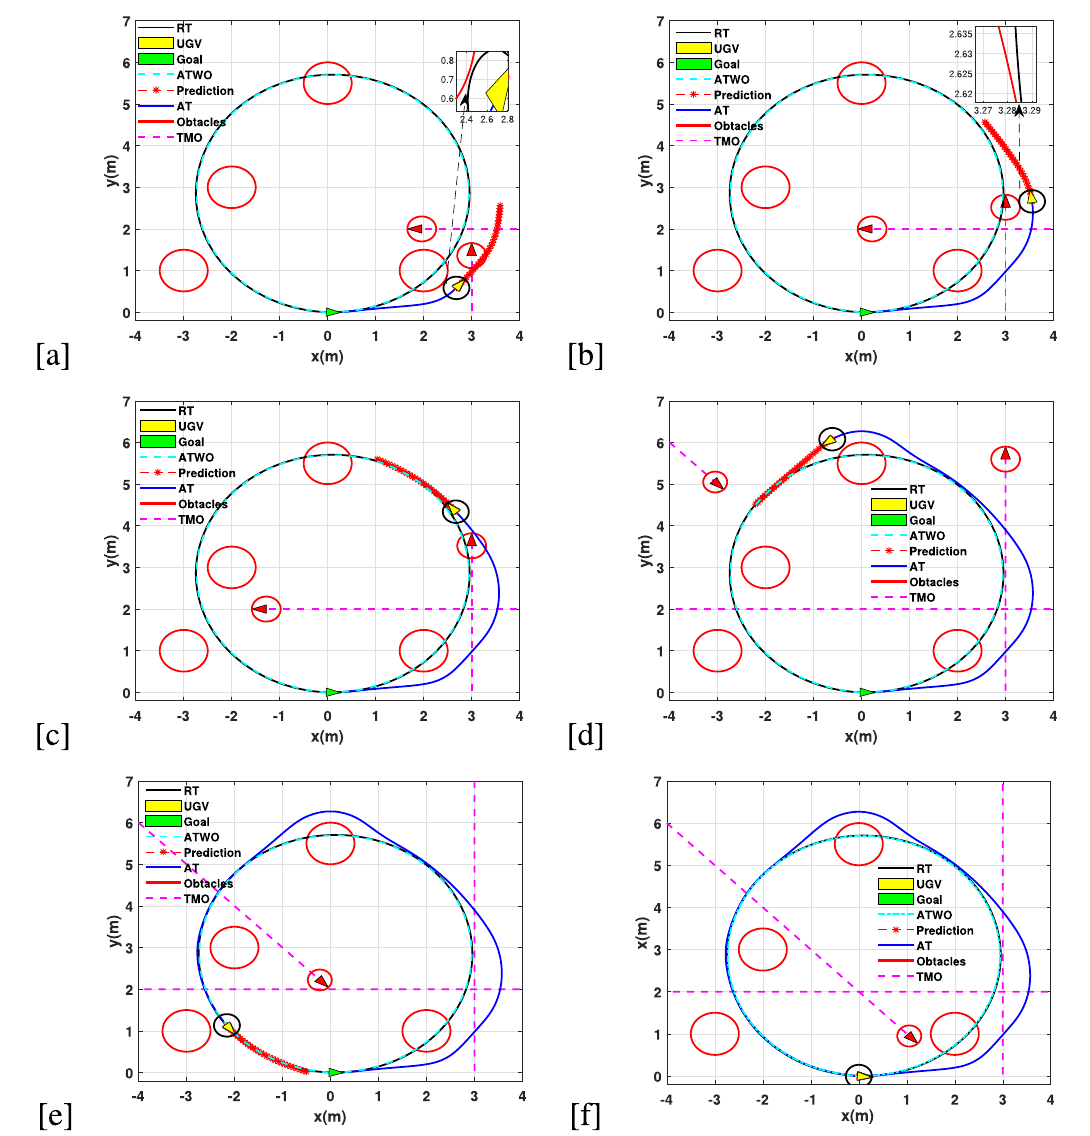
Figure 4. ( a ) Avoided first SO and MO by predicting them. ( b ) Speeds up to safely overtake the incoming vehicle. ( c ) Catching up the RT ( d ) Avoiding another SO and predicting incoming MO to slow down. ( e ) Approaching to the goal location. ( f ) Safely reached to the